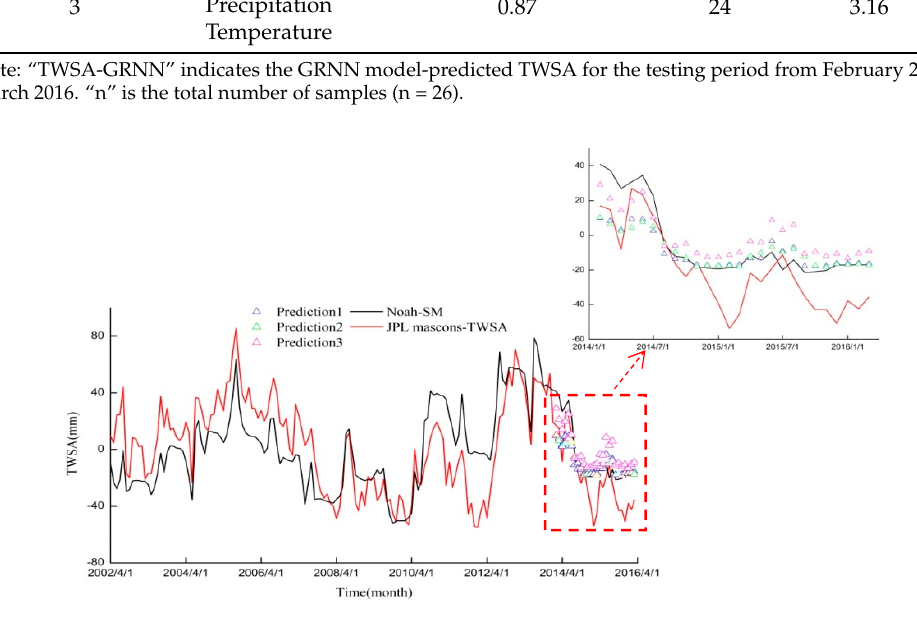
Figure 9. JPL mascon-based TWSAs and SM anomalies (generated by GLDAS Noah) over the Liao River Basin from April 2002 to March 2016. The hollow triangles from February 2014 to March 2016 are the GRNN-generated TWSAs with three types of predictions.